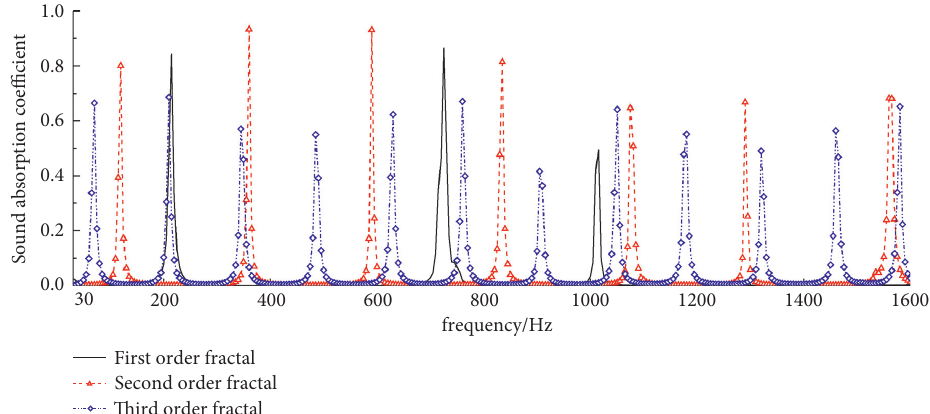
Figure 4: Curve of the sound absorption coefficients of metamaterials of each